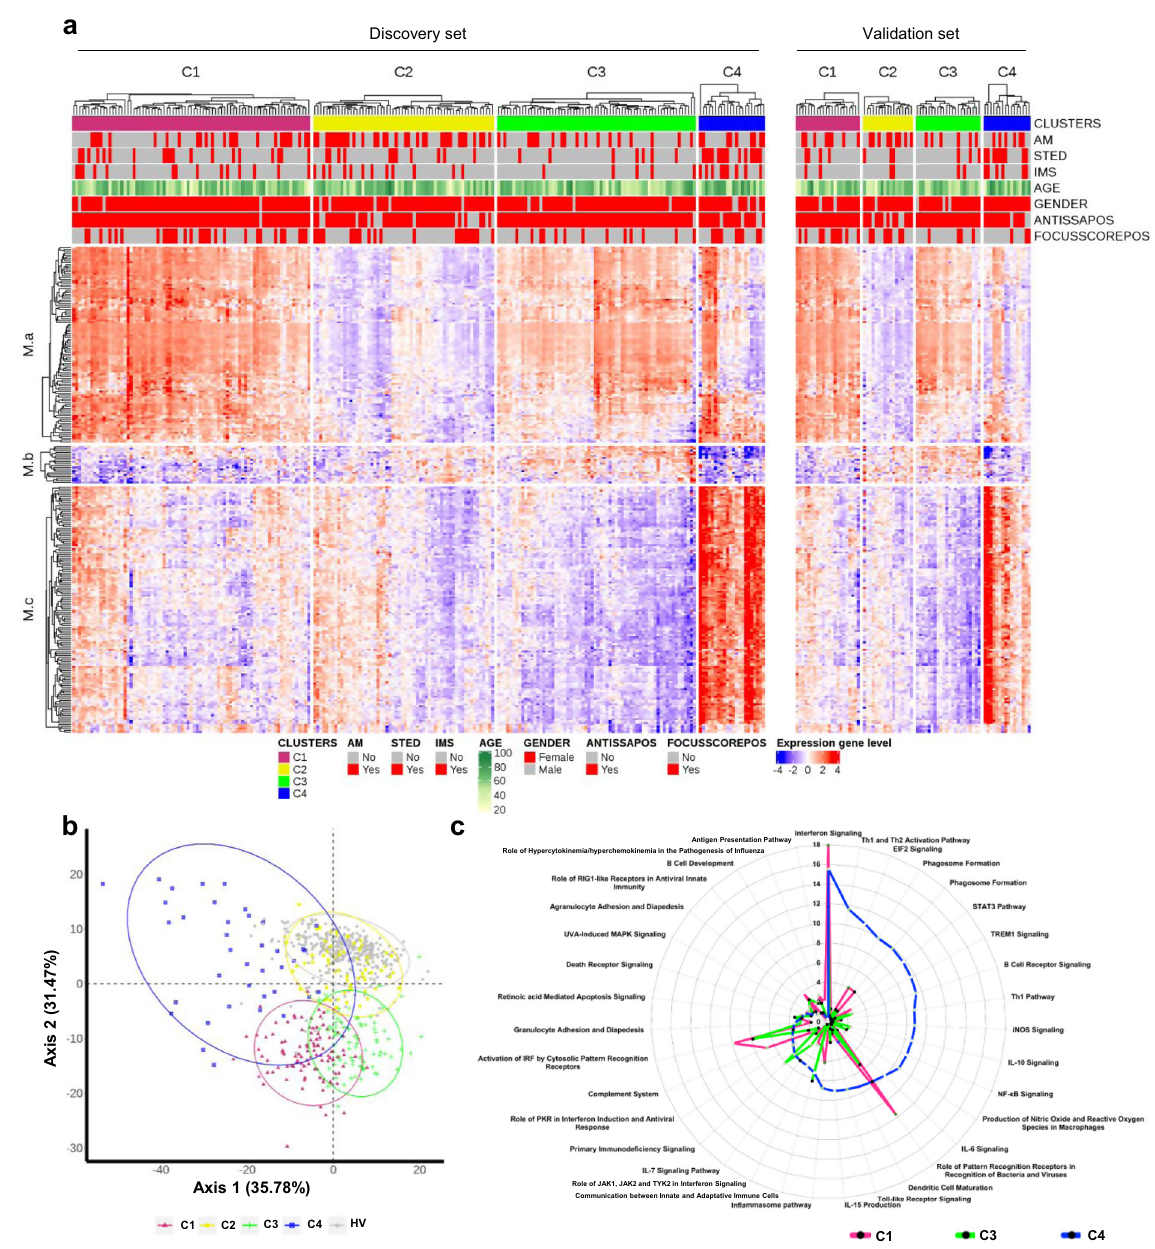
Fig. 1 Molecular pattern distribution is represented by 4 clusters of pSS patients with different canonical pathways. a Heatmap performed for 304 pSS patients (Discovery set: 227, Validation set: 77) showing the distribution of gene transcripts across the 4 clusters. In columns patients are grouped by cluster assignment and in rows genes are grouped by functional modules. Each subset of patients (discovery set on the left and validation set on the right) is presented separately. Red represents overexpression and blue represents under-expression. At the top of the fi gure annotations show: each of the treatment groups for each individual (AM: antimalarials, STED: steroids and IMS: immunosuppressors, red represents patients with treatment and gray represents patients without treatment), age (levels of yellow to green with yellow for younger patients and dark green for older patients), gender (red represents woman and gray represents man), ANTISSAPOS: anti-SSA/Ro antibody positivity, FOCUSSCOREPOS: focus score of ≥ 1 foci/mm 2 (red represents focus score of ≥ 1 foci/mm 2 and gray represents focus score of <1 foci/mm 2 ). b Scatterplot of the fi rst two components PCA (performed for 304 pSS patient and 330 HV) model showing clearly de fi ned clusters in signature gene. HV (gray dot) are confused with C2 cluster (yellow dot). c Top 20 most signi fi cant canonical pathways for each cluster. Radar plots are represented according to ‒ log ( p -value) (Fisher ’ s exact test) associated to the most signi fi cant pathways of each cluster; C1 (pink), C3 (green), C4